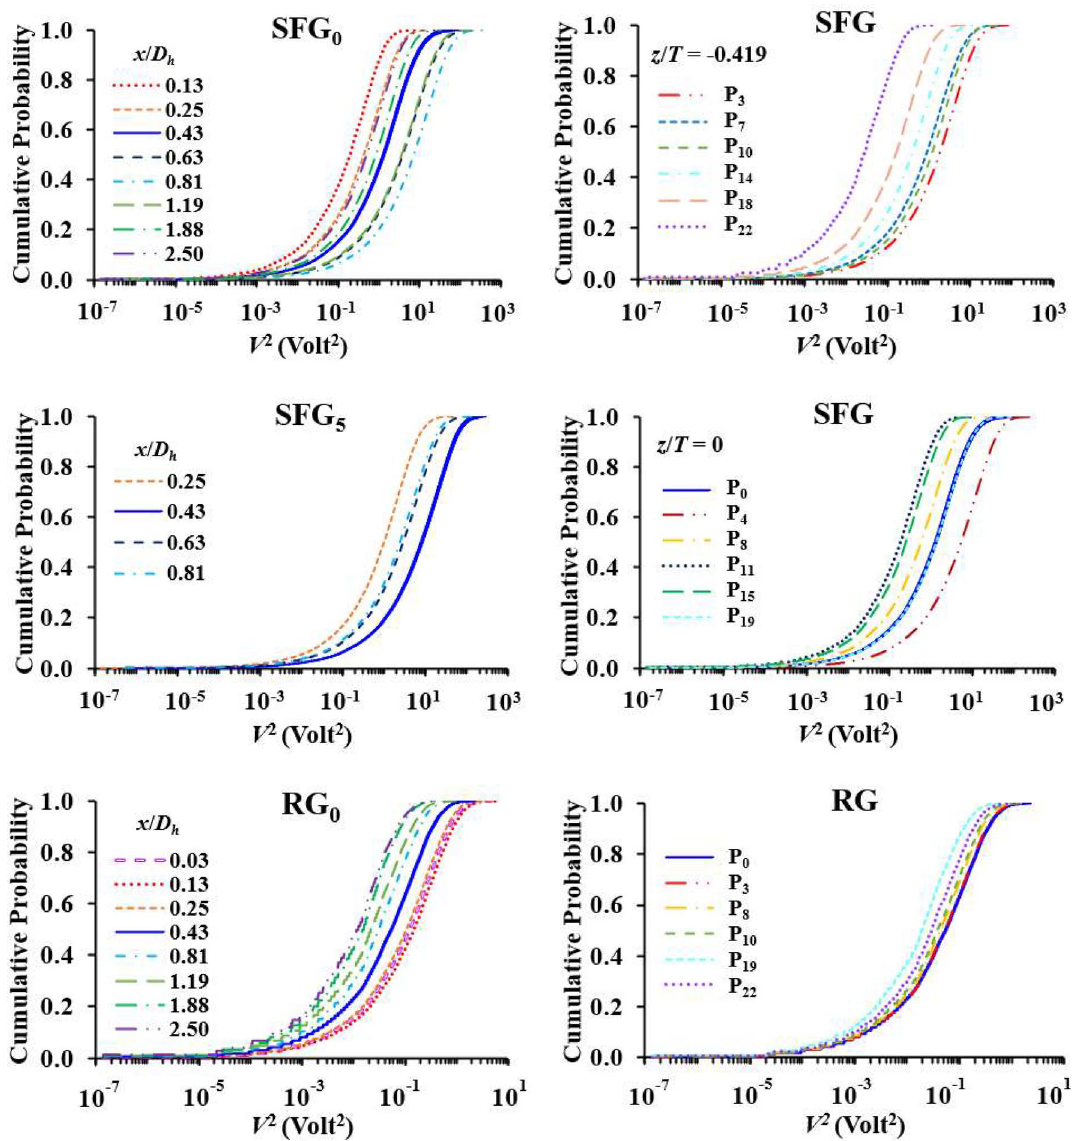
Figure 13. Cumulative probability of V 2 at different streamwise locations along SFG( P 0 , P 5 ) and RG centreline (left), and at x / D h = 0.425 downstream from the SFG and RG